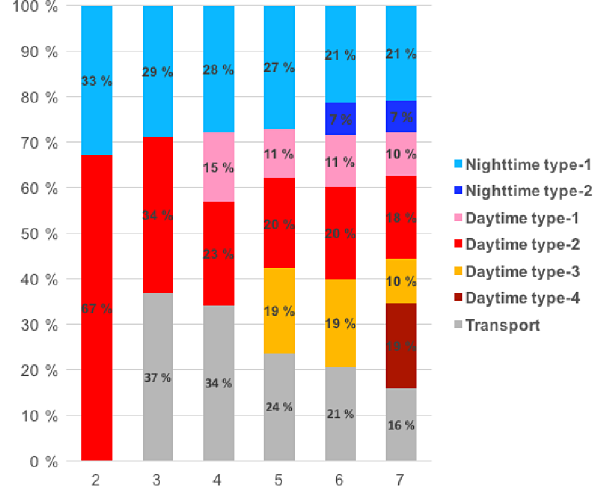
Figure 4. Source allocation from two- to seven-factor PMF solu-